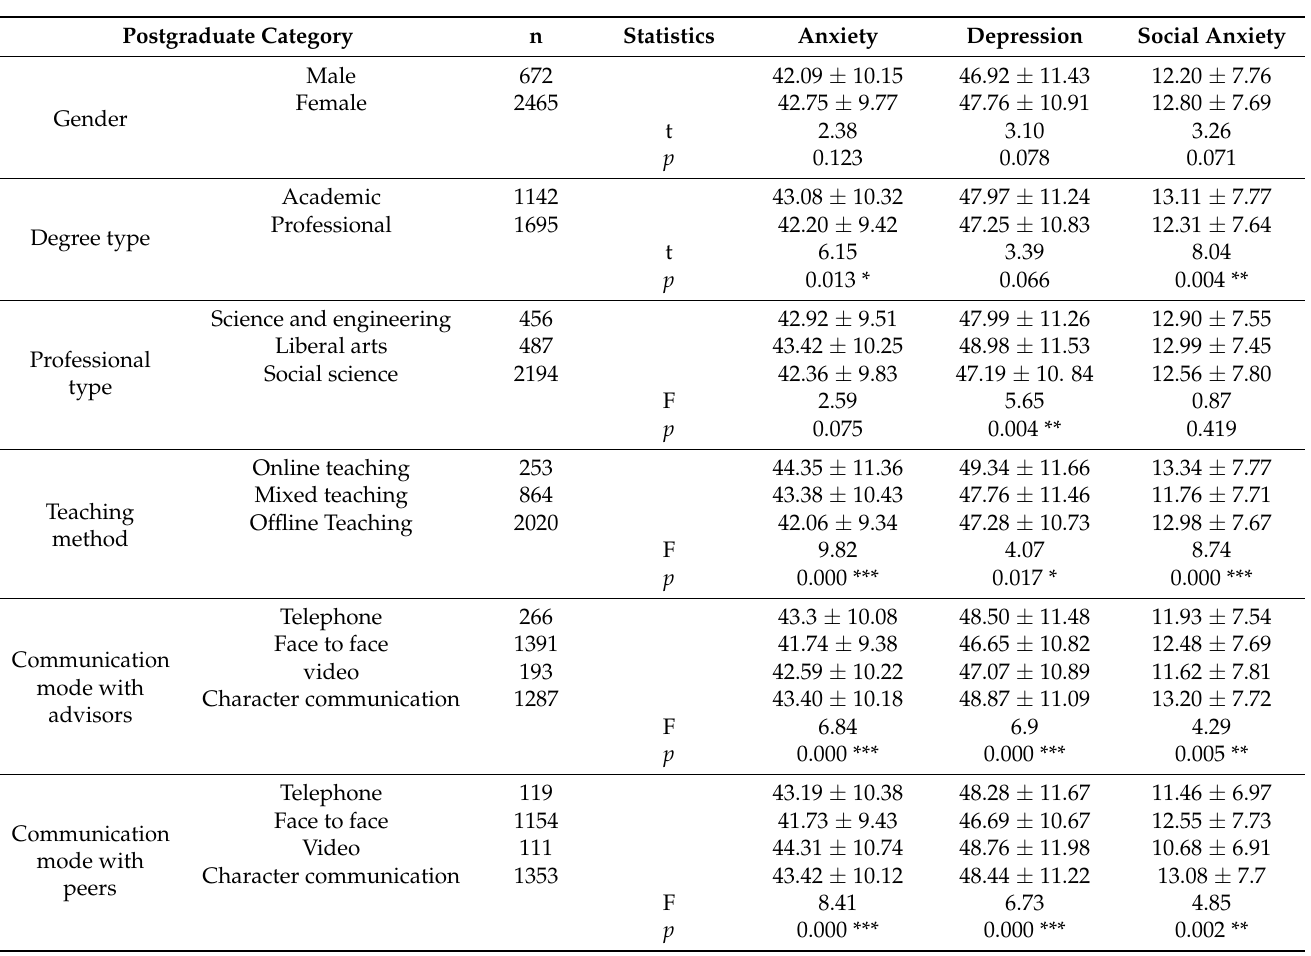
Table 4. The score comparison of different types of postgraduate students (M ±